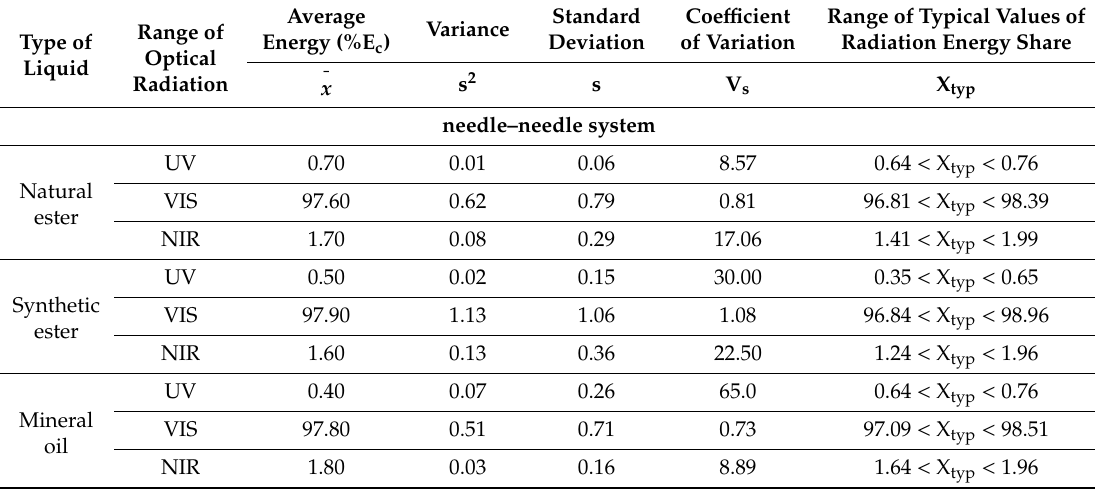
Table 3. Comparison of the share of optical radiation emitted by electric